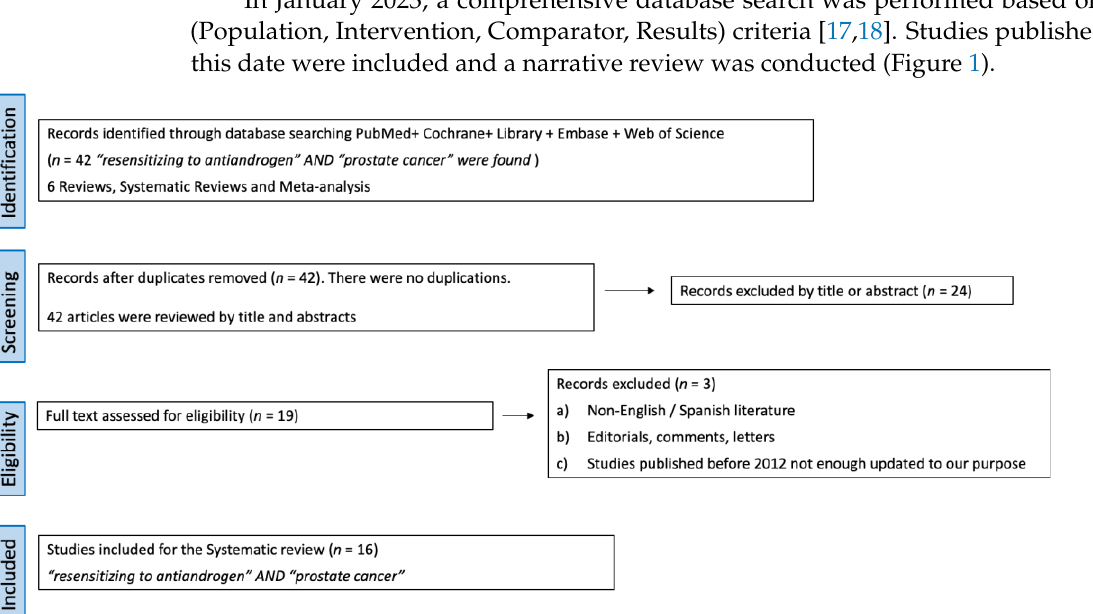
Figure 1. Preferred reporting items for Systematic Reviews and Meta-analyses (PriSMa) criteria and population, intervention, comparator, outcomes (PICO) methodology applied to the article.